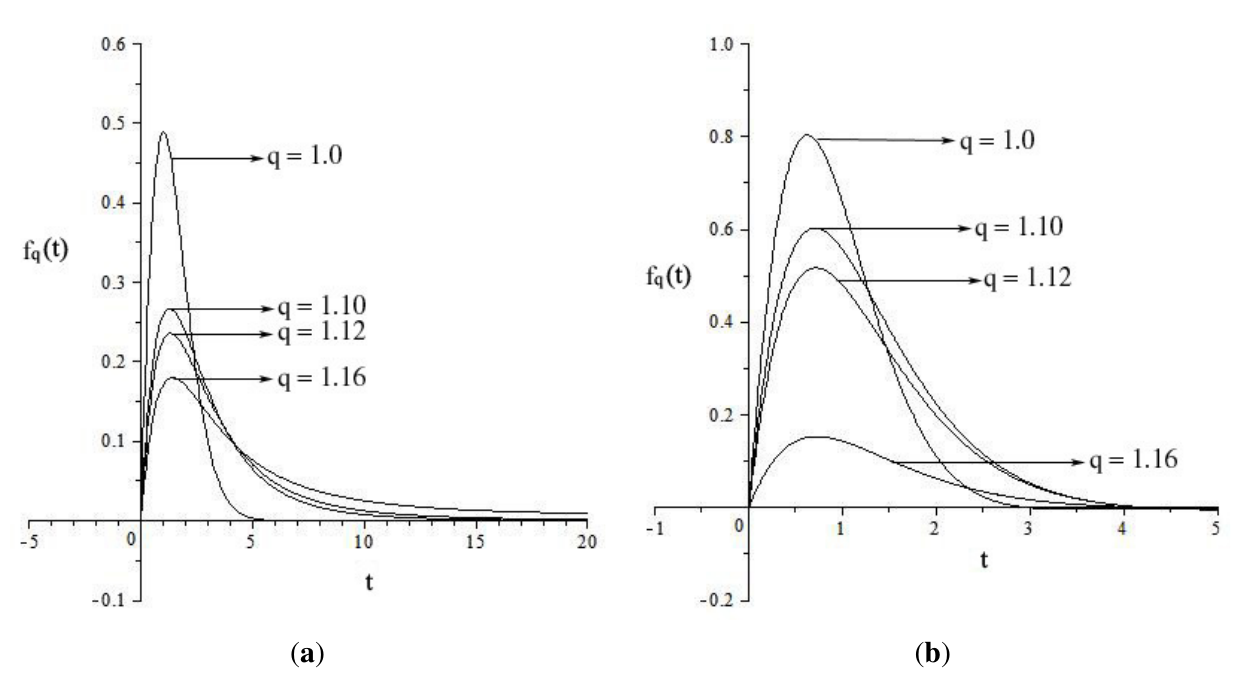
Figure 4. ( a ) q -gamma Bessel model for δ = 0 . 5 , q > 1 ; ( b ) q -gamma Bessel model for δ = − 0 . 5 , q > 1